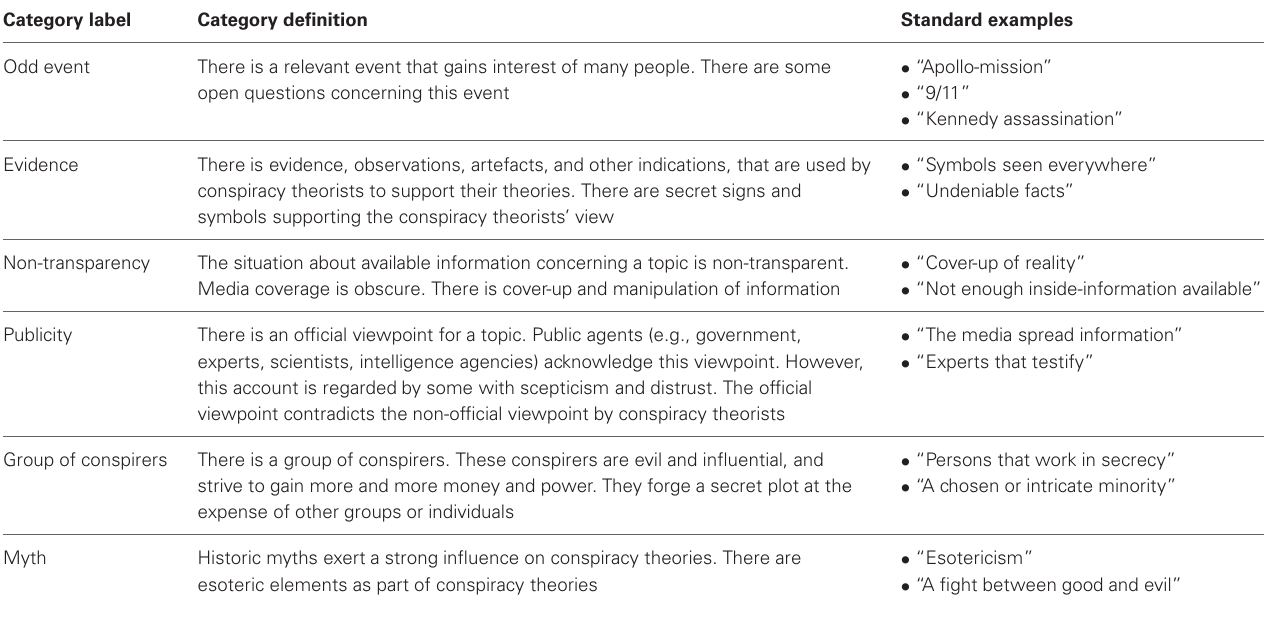
Table 1 | Items generated by a bottom-up process of categorization, ordered descending by